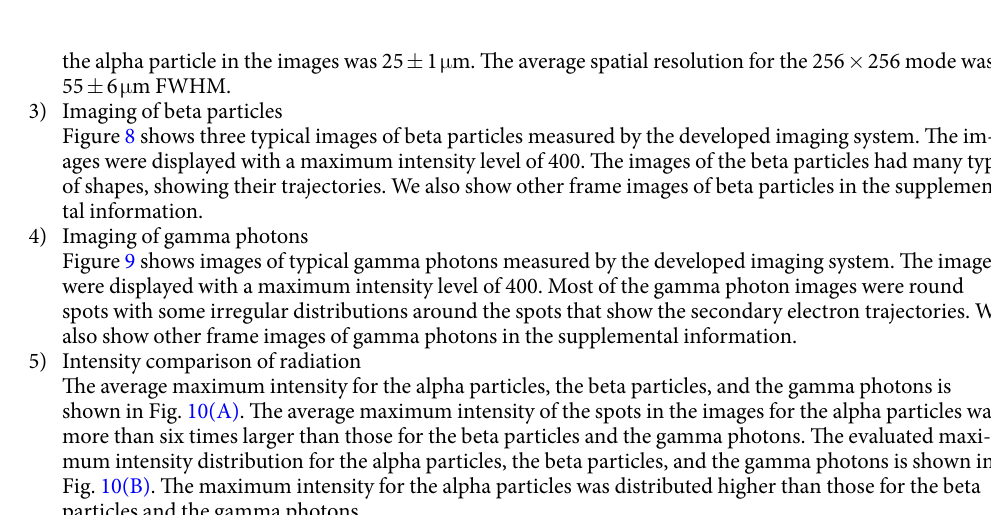
Figure 9. Images of typical gamma photons measured by developed radiation imaging